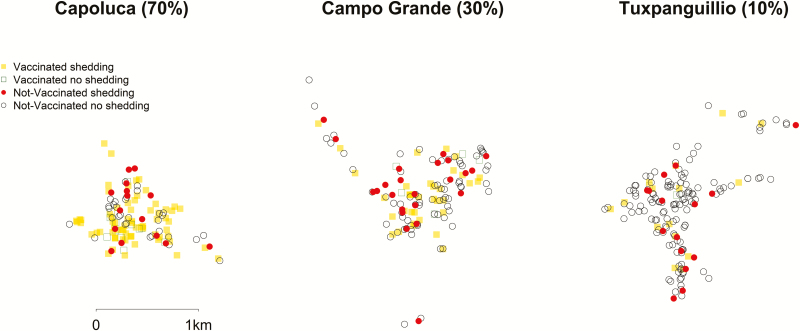
Maps of study areas.